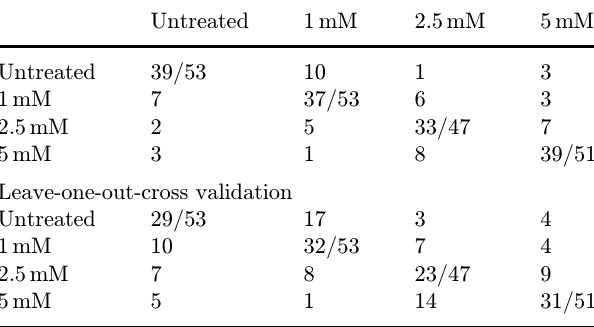
Table 1. Summary of classifcation after PC-LDA and LOOCV between control and PTX-treated MDA-MB-231 cells (diagonal elements are true positive predictions and ex-diagonal elements are false positive